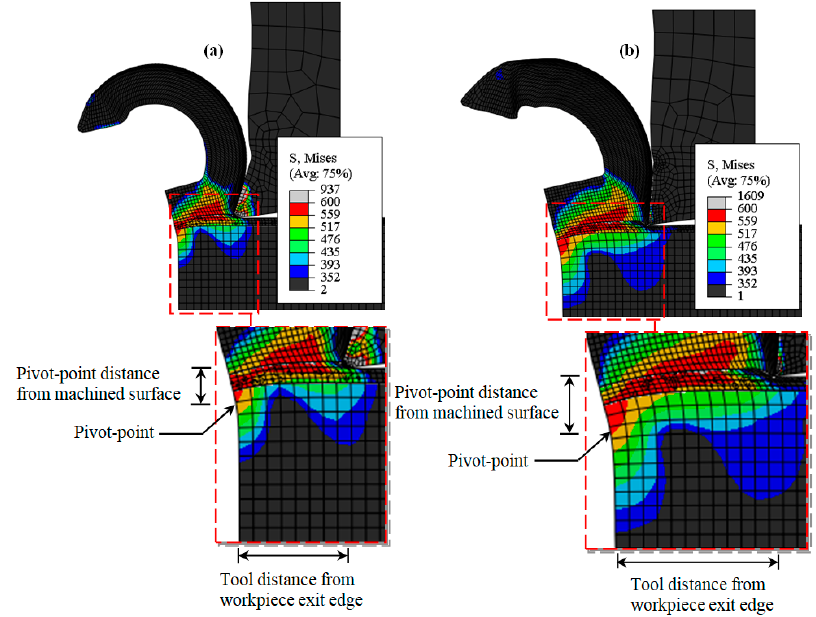
Figure 4. Von-mises stresses at Z = 0 ( a ) V C = 1000 m/min, f = 0.3 mm/rev, γ = 17.5 ◦ ( b ) V C = 800 m/min, f = 0.4 mm/rev, γ = 5 ◦